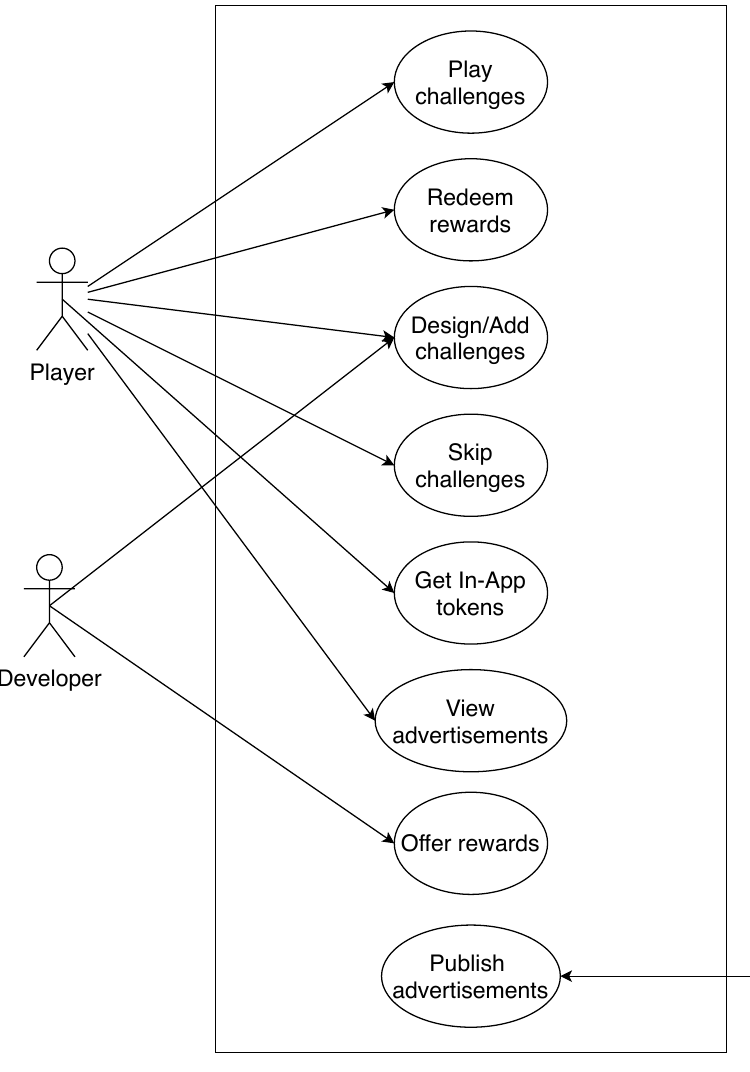
Figure 2. Actors’ interaction with the mobile gaming